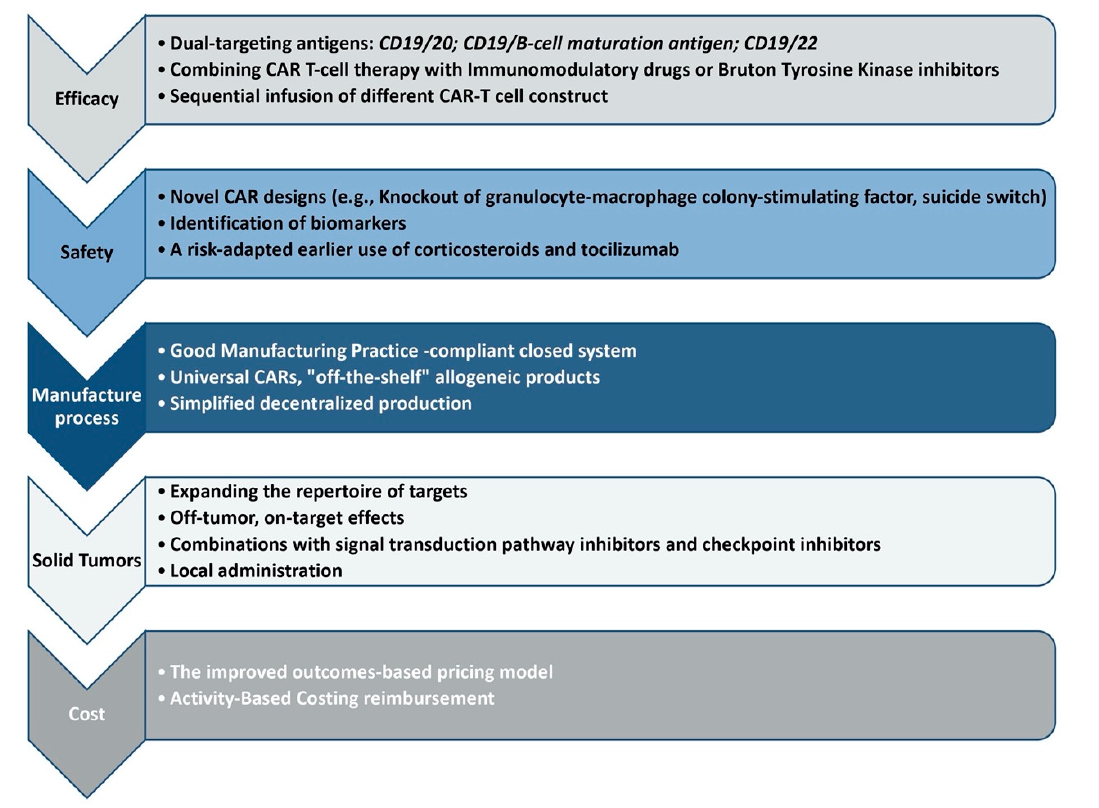
Figure 1. Future directions for chimeric Antigen Receptor Cell Therapy (CAR-T)